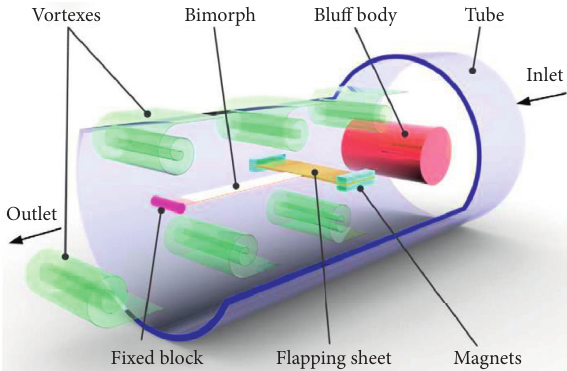
Figure 10: Schematic of the VSIV piezoelectric energy harvester [103].